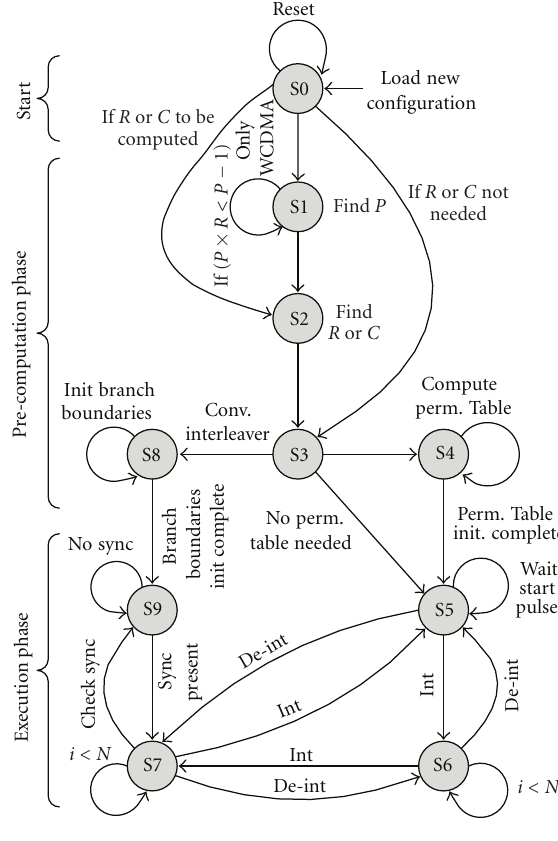
Figure 5: FSM state